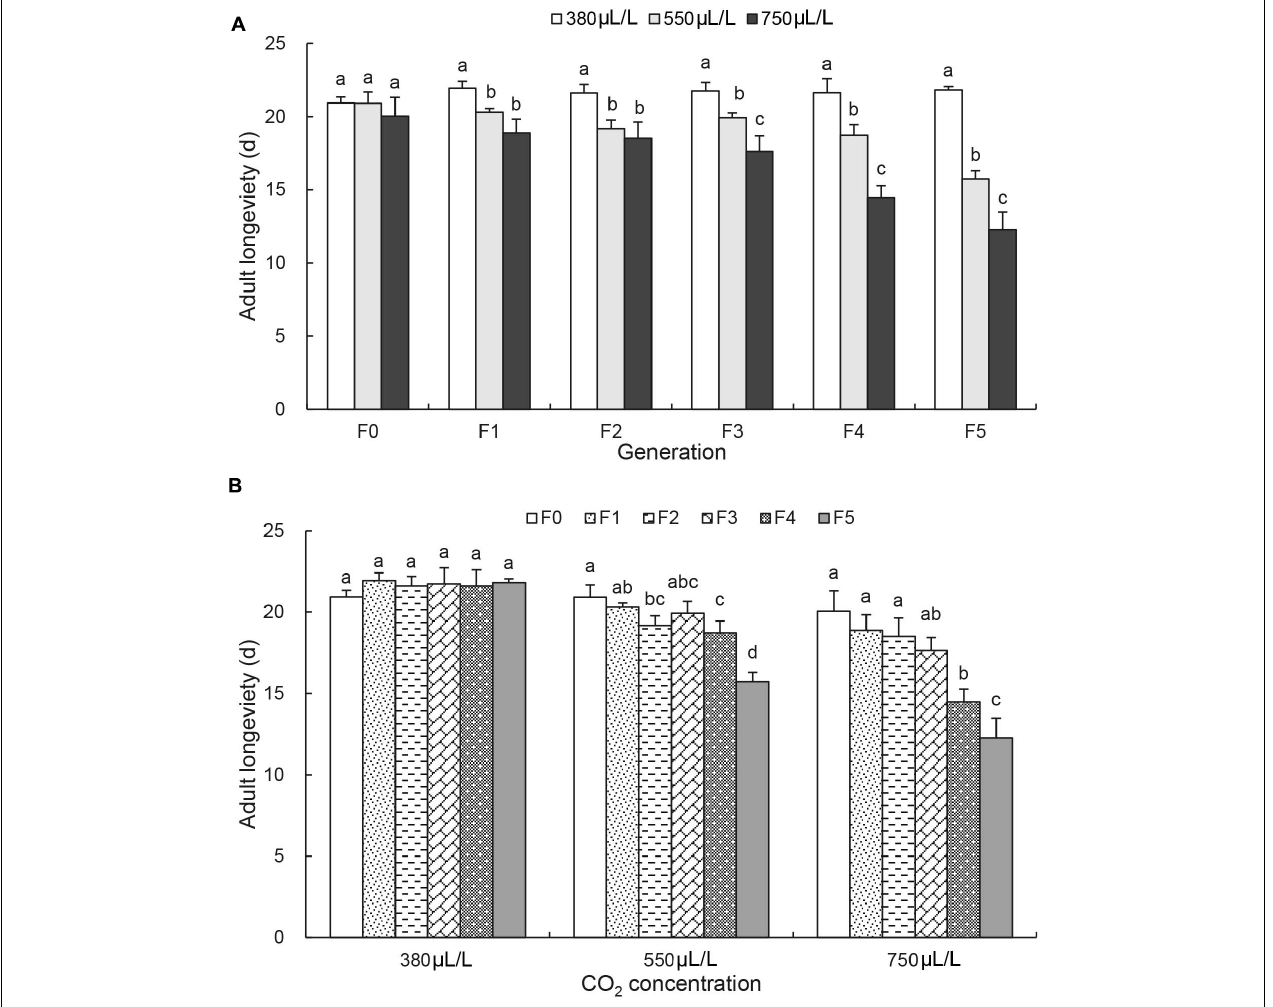
FIGURE 2 | Effects of CO 2 and generations on the adult longevity of Acyrthosiphon pisum . (A) Comparison of the effect of CO 2 levels (380, 550, and 750 µ L/L) at each of six generations (F 0 –F 5 ). (B) Comparison of the effect of generations under each of CO 2 levels (380 µ L/L, elevated 550 and 750 µ L/L). Different lowercase letters indicate significant differences between CO 2 levels at each generation (A) and between generations at each CO 2 level (B) as determined by one-way ANOVA Tukey’s HSD test at p <